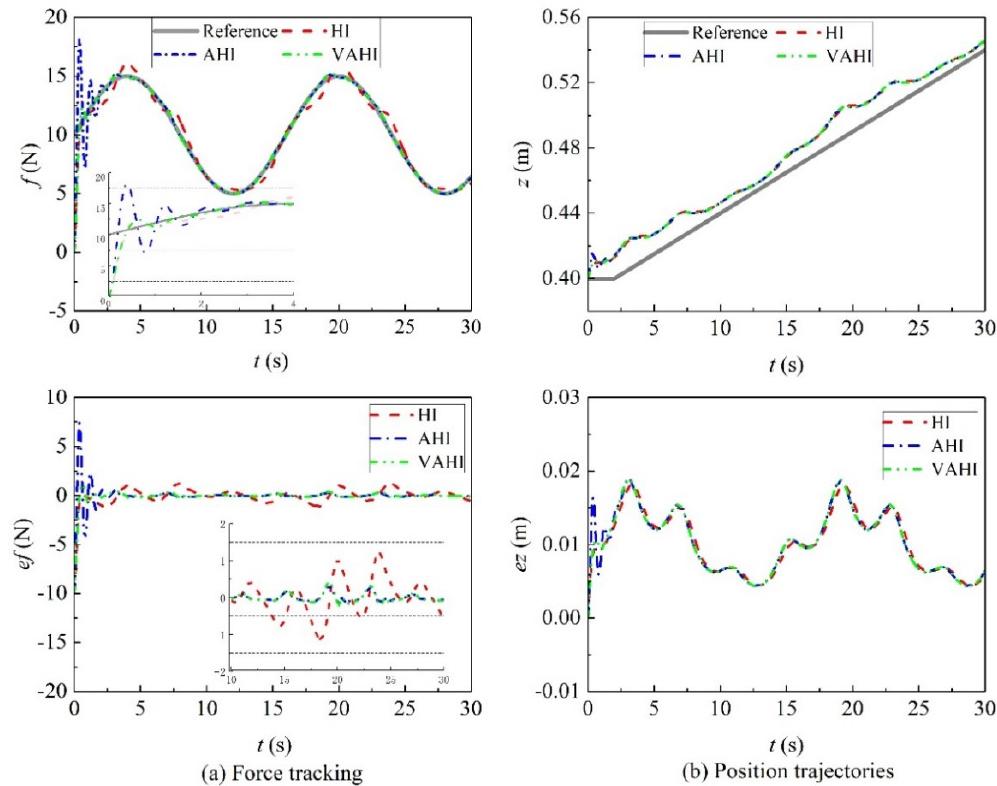
Figure 9. Tracking of the varying force with HI, AHI, and VAHI control schemes in the slope